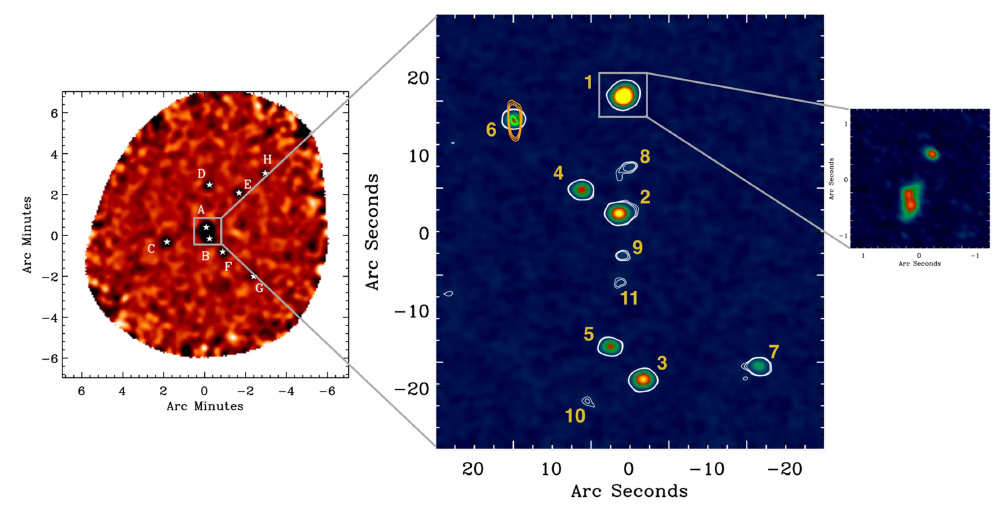
Figure 10. The Distant Red Core, a proto-cluster at z = 4.002. ( left ) The 870 µ m LABOCA map (smoothed to a resolution of 27 (cid:48)(cid:48) ) reveals 8 sources, an overdensity relative to field submm number counts (e.g., [543]). ( middle ) ALMA 2 mm continuum map of LABOCA sources A and B, which resolves into 11 discrete sources, 10 of which are in the proto-cluster. Orange and green contours show radio continuum from ATCA and JVLA, respectively. ( right ) A high-resolution (0.12 (cid:48)(cid:48) ) ALMA 870 µ m map of source DRC-1, which resolves further into three star-forming clumps. Figure adapted from Figure 1 in Oteo et al. [328], reproduced by permission of the